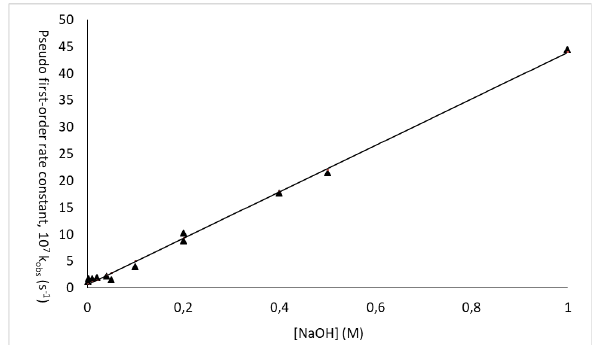
versus [NaOH] for obs at 60°C. The solid line is 2